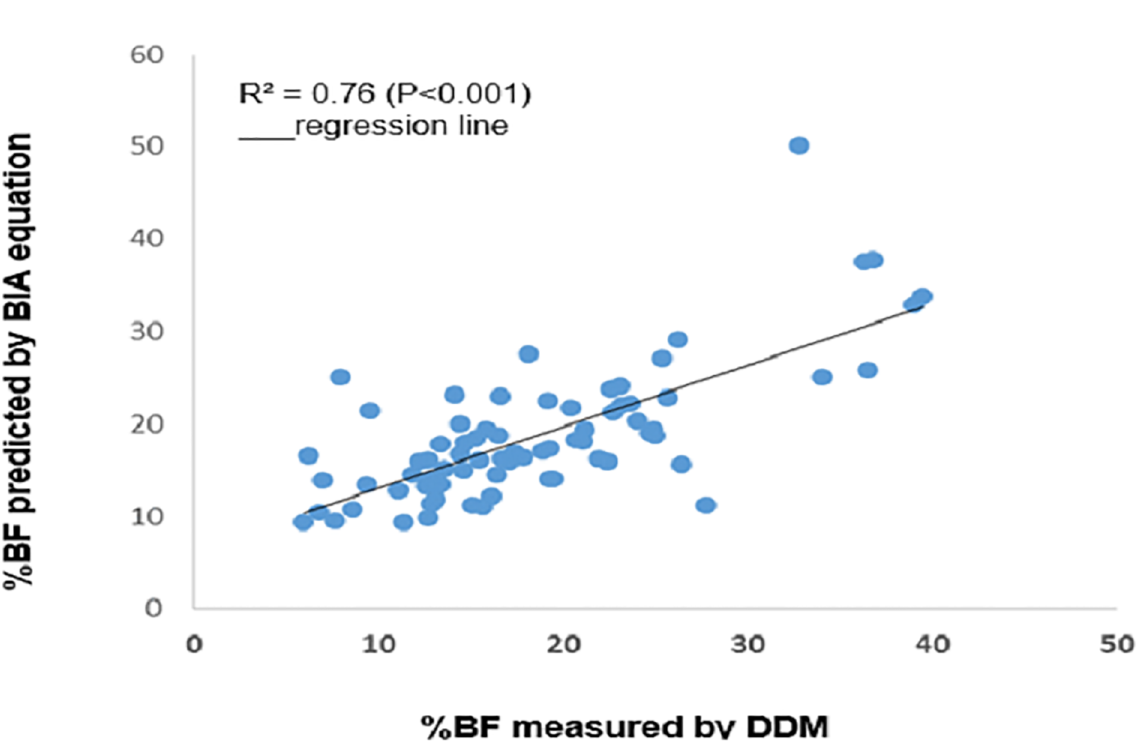
Fig 2. Correlations between %BF values from DDM and BIA were performed and r value measure the degree of linear connection between two variables.